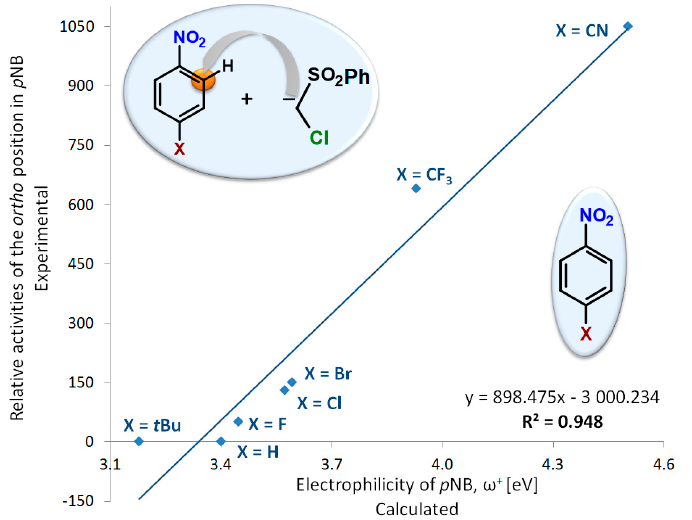
Table 1. Experimental relative activities [61] and calculated electrophilicity potential ω + (eV) of para substituted nitro benzenes.